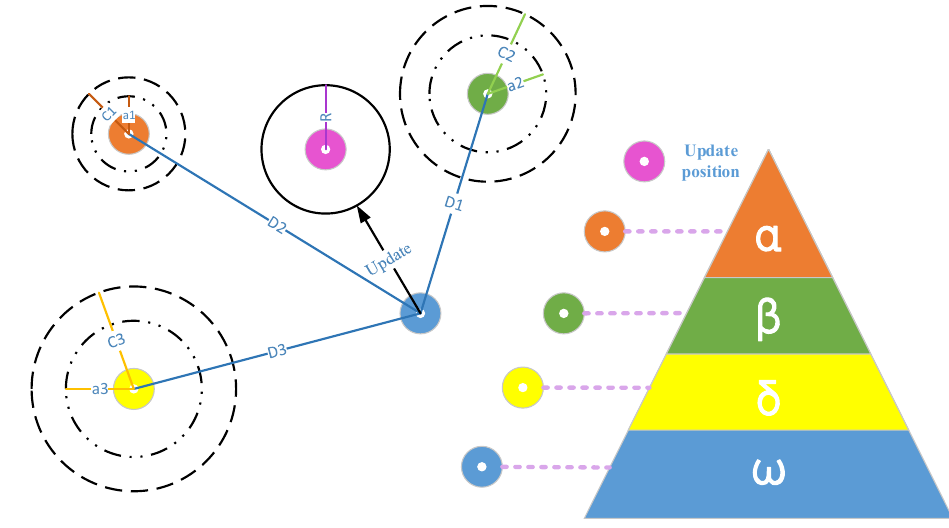
Figure 1. The diagram of GWO (Grey Wolf Optimization) algorithm.